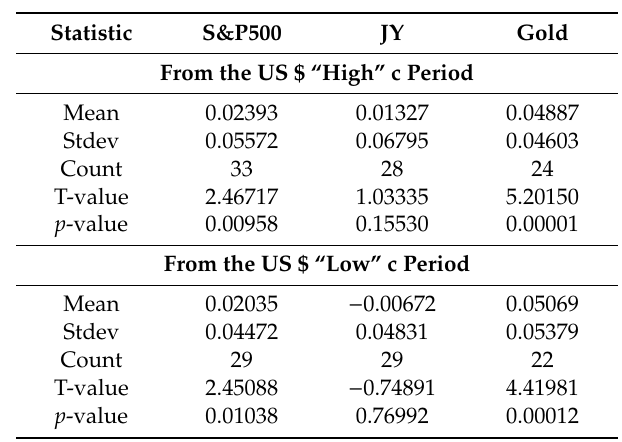
Table 1. h c − h T (HRs based on US $s).